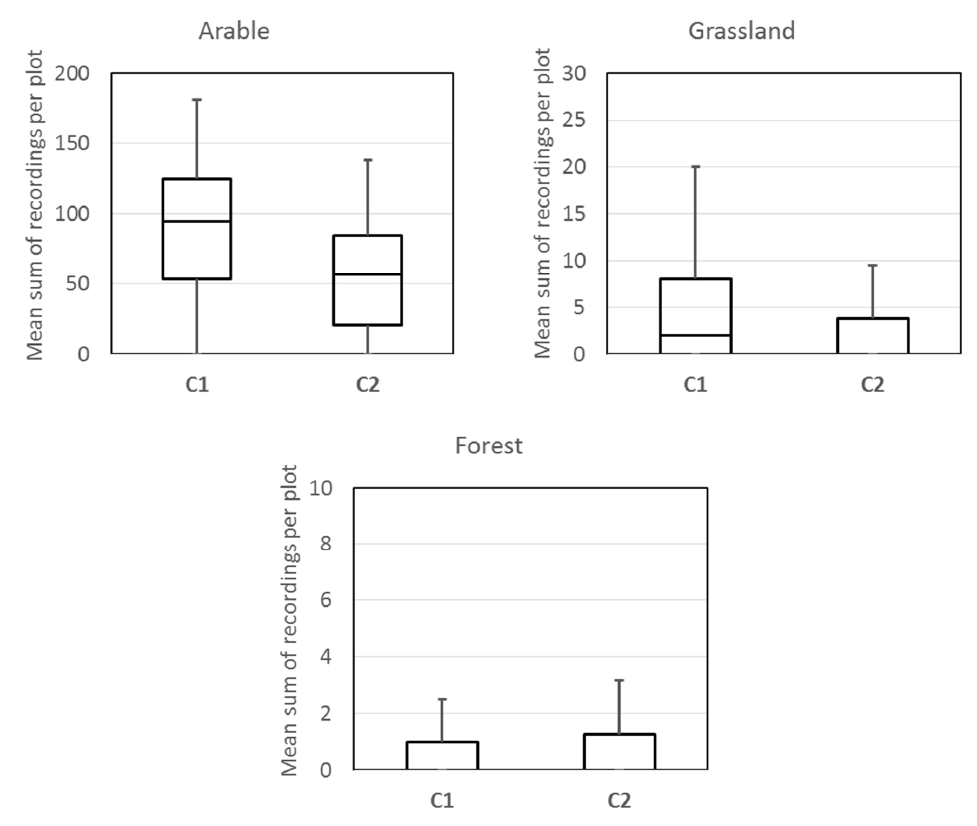
Figure 8. Changes in the abundance of the bird guild representatives at three types of single sample plots between the two campaigns (C1: 1999–2002; C2: 2013–2015). plots between the two campaigns (C1: 1999–2002; C2: